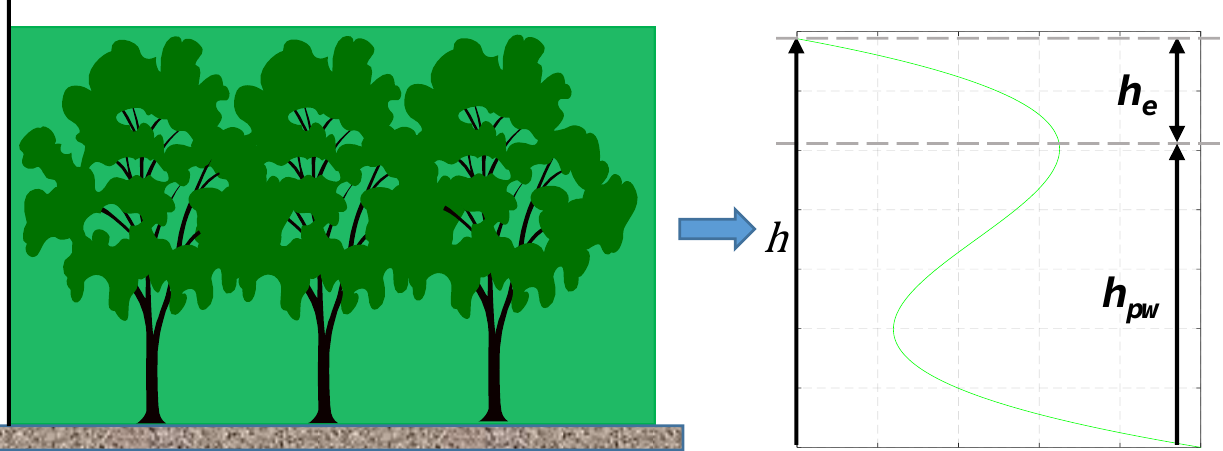
Figure 4. The relationship between canopy peak height and forest height.